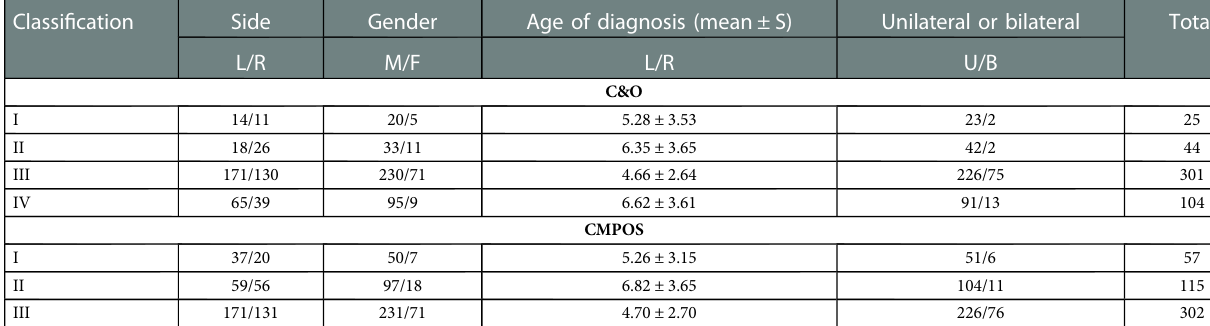
TABLE 1 Demographics information of patients distribution in different classi fi cation.